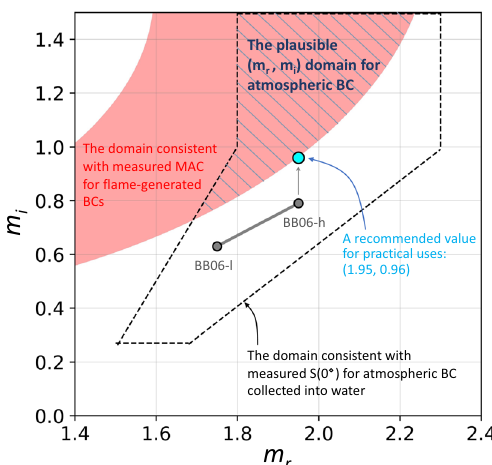
Fig. 2 Illustrating the three-different ( m r , m i ) domains for the complex refractive index of BC.: 1) The domain consistent with measured S (0°) for atmospheric BC (enclosed by black-dashed lines), 2) the domain consistent with measured MAC for various flame-generated BCs (red-filled area), and 3) the domain constrained by both MAC- and S(0°)-measurements (Moteki et al. 2023). The conventional assumptions BB06-l (1.75 0.63i) and BB06-h + (1.95 0.79i) (gray-filled circles) and the recommendable value for + practical uses 1.95 0.96i (blue-filled circle) suggested by Moteki + et al. (2023) are also